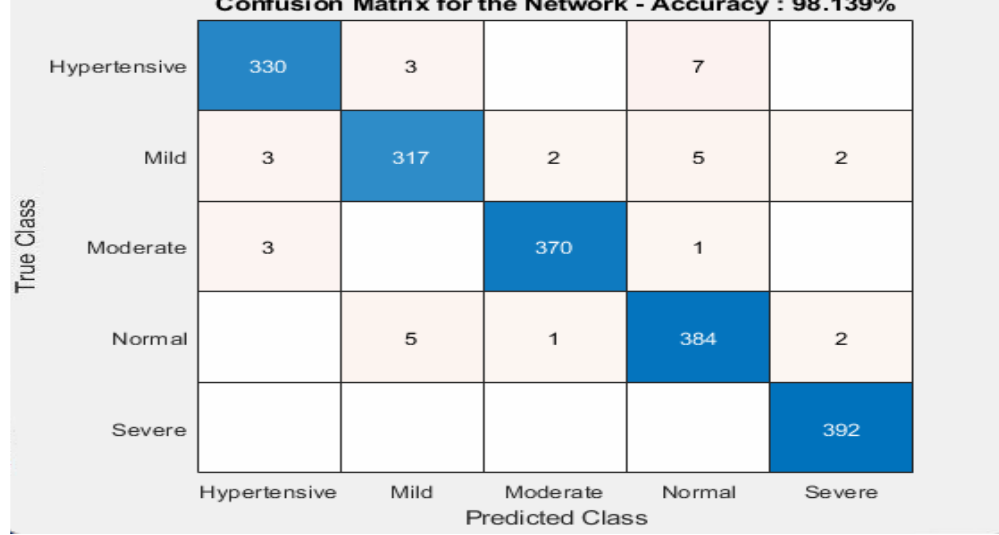
Figure 11 . Accuracy of Messidor and ODIR dataset.